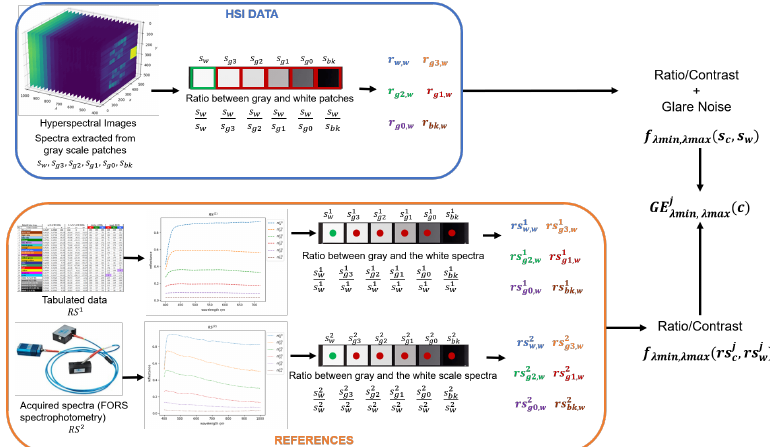
Figure 8. Graphical explanation of the Glare Evidence (GE) formula. The numerator is the ratio between the gray and white patches of the HSI system, which includes the glare effect introduced by the lenses in the imaging system. The denominator is the ratio between the gray and white spectra obtained from the two references (pointwise measuring systems). Thus, GE measures the noise introduced by the imaging system which is represented by the difference between the two computed